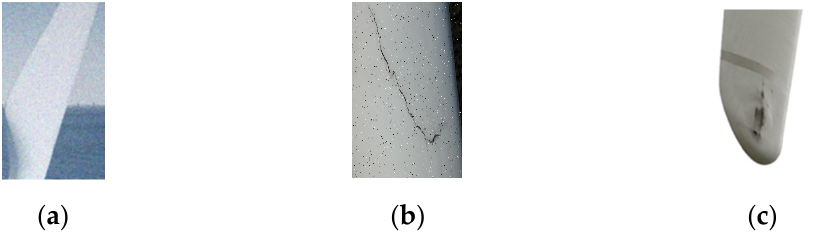
1008 pictures with cracks, and 1040 pictures with surface shedding.